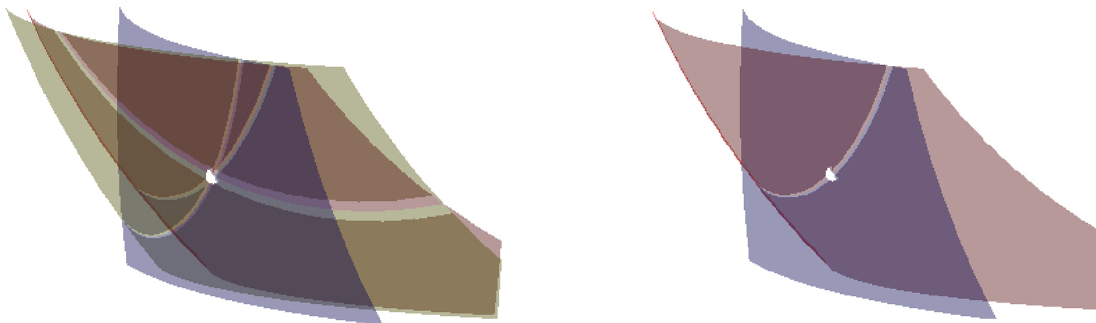
Figure 8. Partial enlarged view of intersection line of torus.